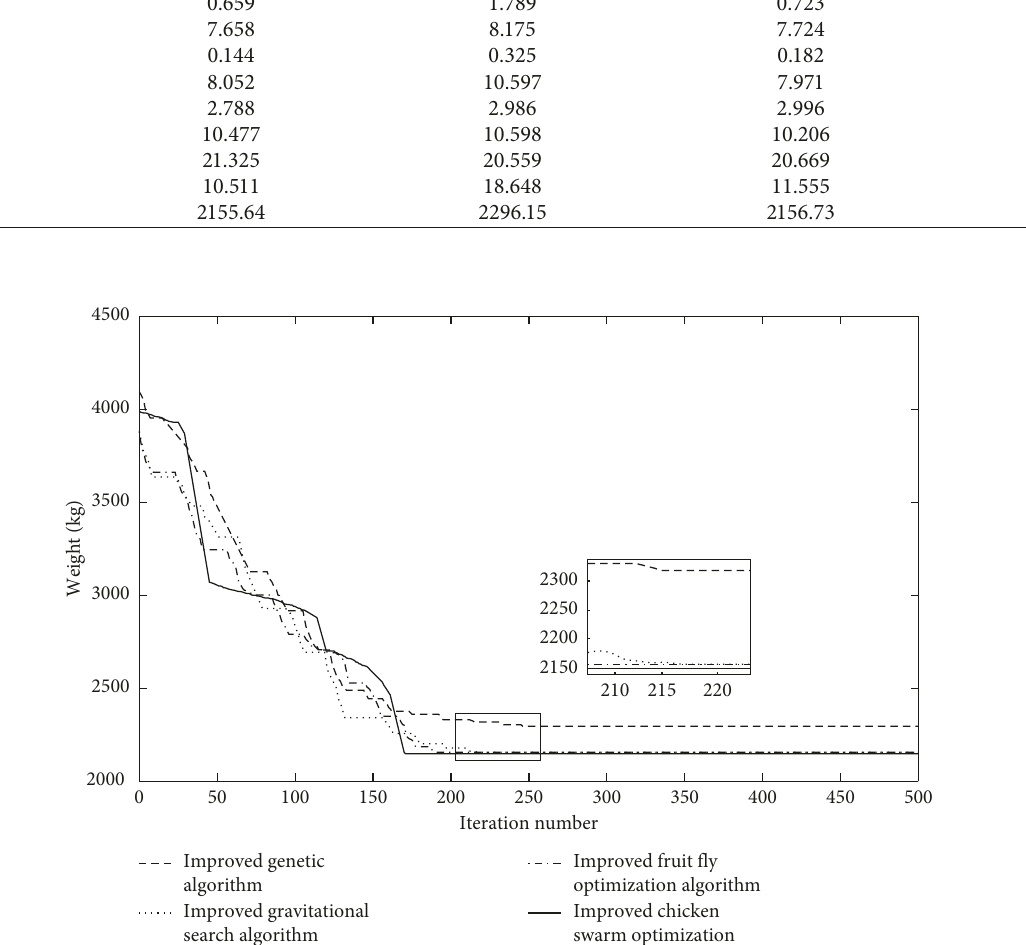
Figure 14: Four algorithms for finding the iterative curve of